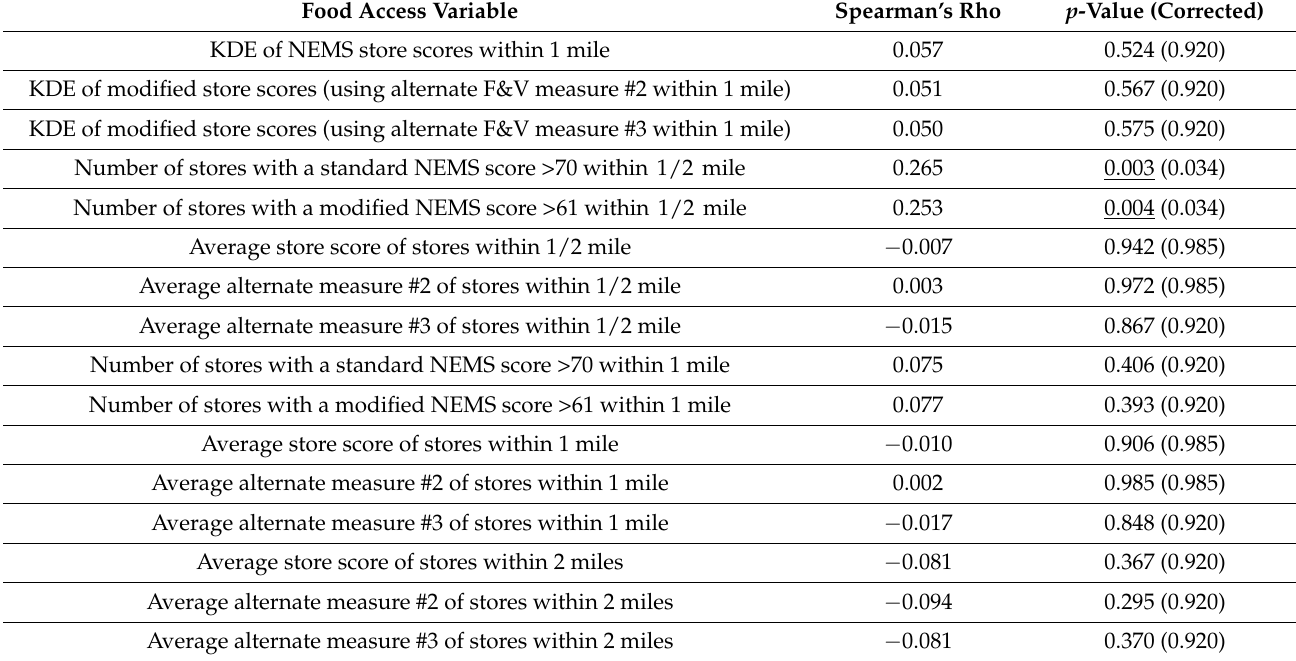
Table 2. Association between objective and perceived food